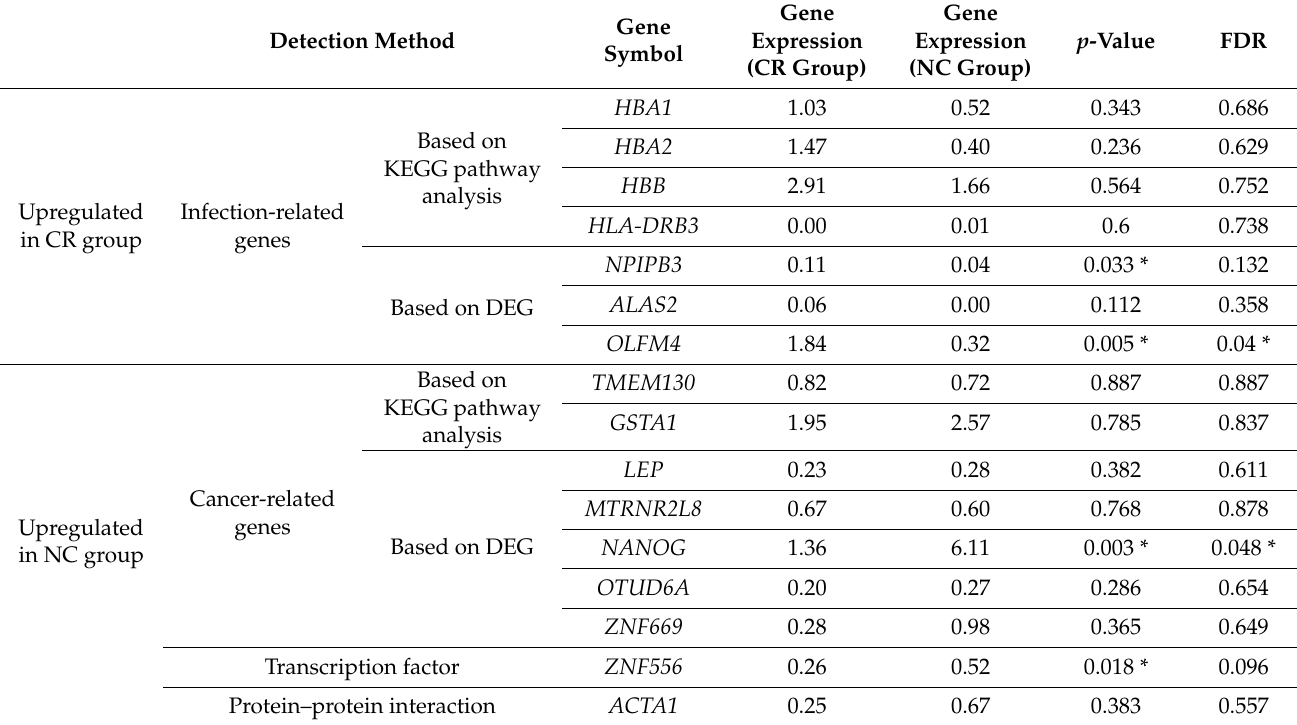
Table 3. Detected candidate genes: results of validation study based on real-time